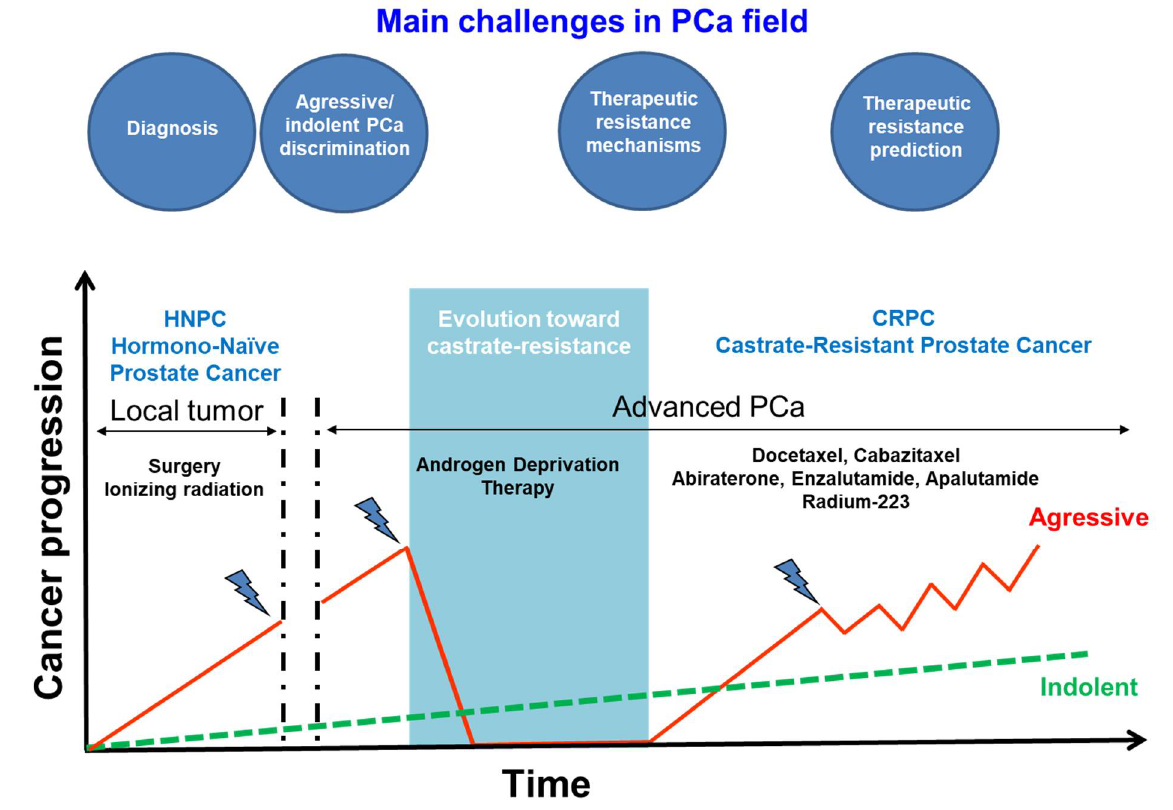
Figure 1. Clinical evolution of PCa and the main challenges for